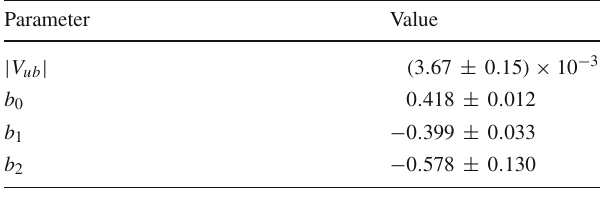
Table 83 Best fit values and uncertainties for the combined fit to data, LQCD and LCSR results